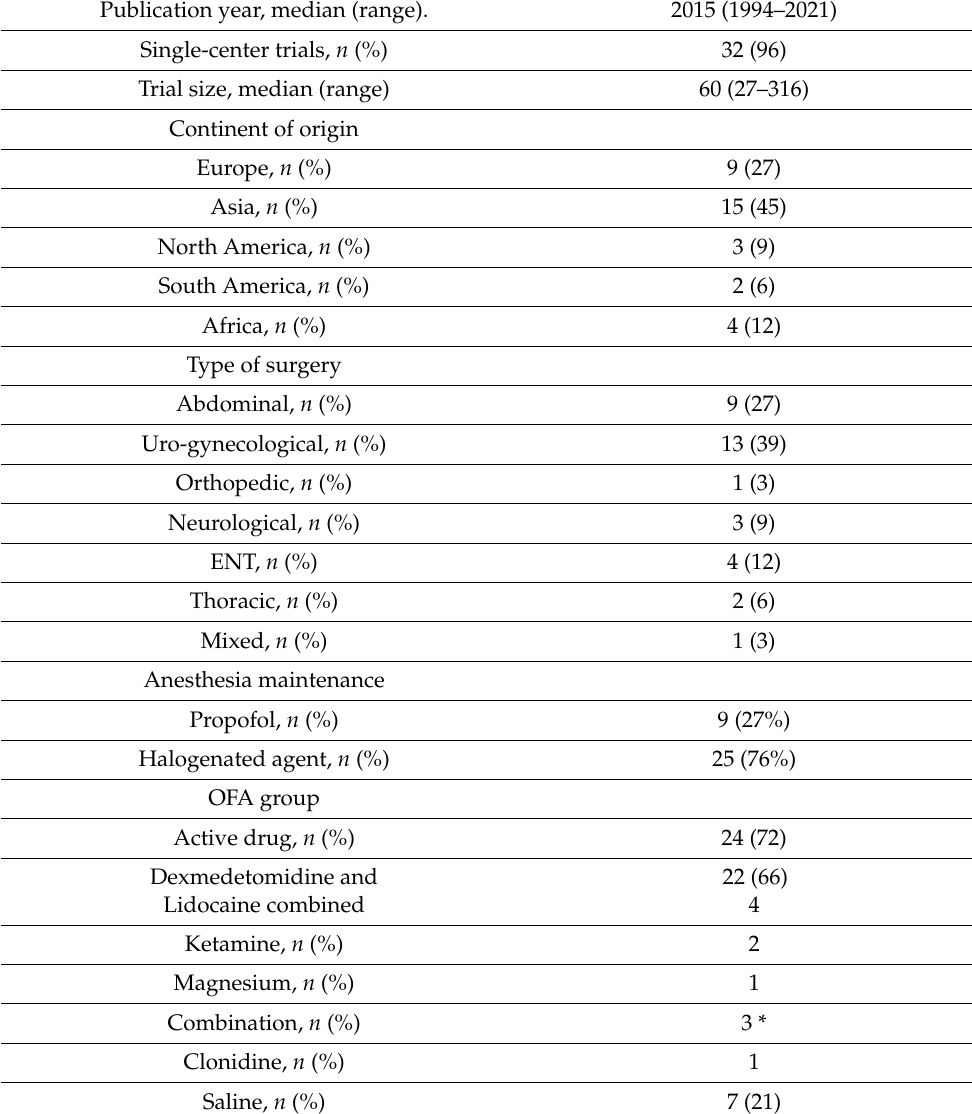
Table 1. Characteristics of the 33 trials included in the meta-analysis. Publication year, median